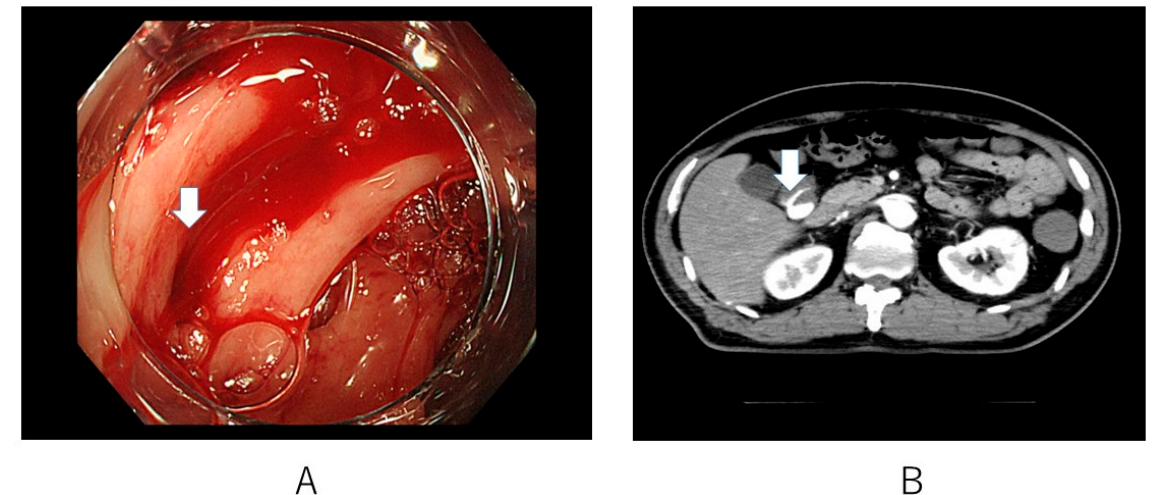
Figure 2. Definite colonic diverticular bleeding. ( A ) Bleeding from diverticula is observed with endoscopy (arrow). ( B ) Extraversation of the contrast medium into the colon lumen is demonstrated with computed tomography (arrow).